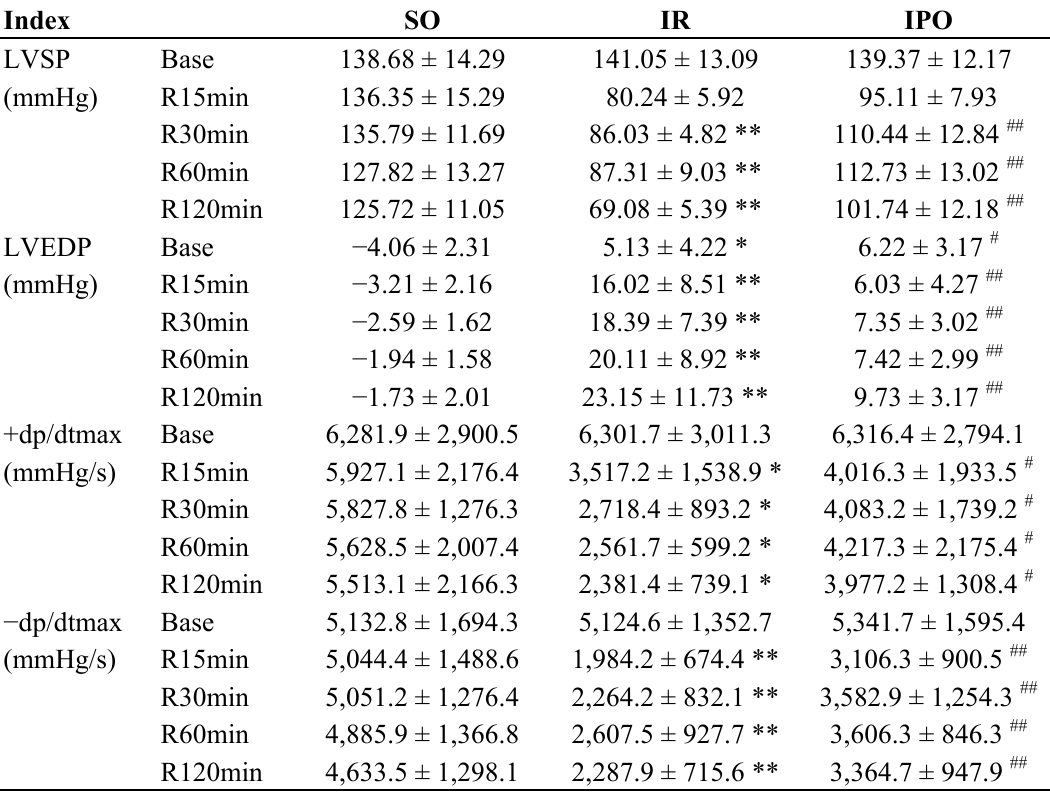
Table 2. Effect of ischemic postconditioning on the value of LVSP, LVEDP, and ±dp/dtmax in IR rats.